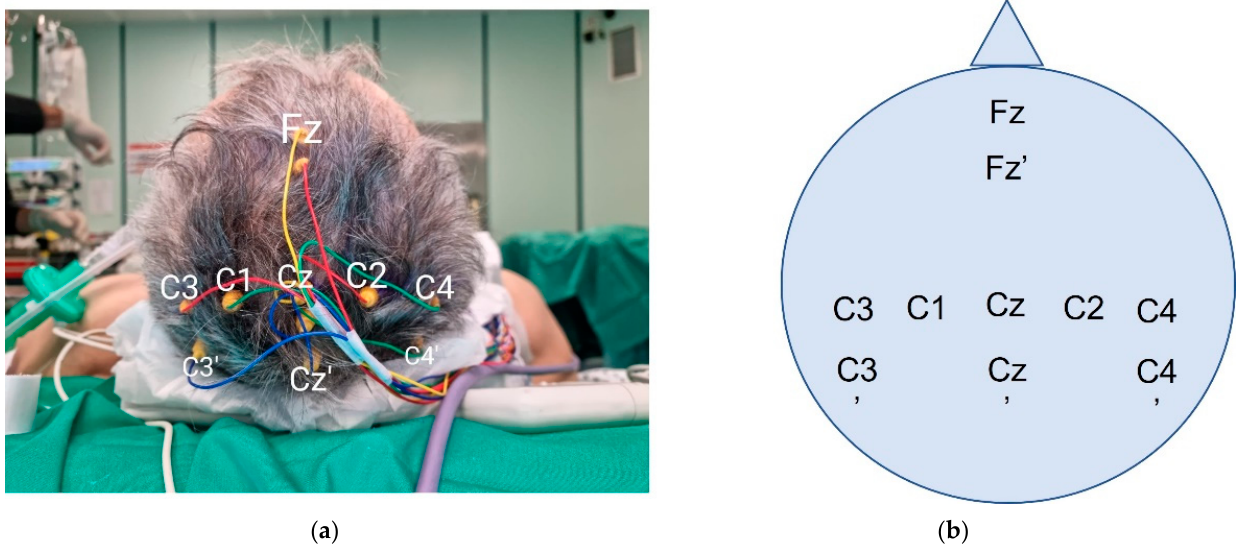
Figure 4. Intraoperative corkscrew scalp positioning (photograph ( a ) and schema ( b )). C3 and C4 are both represented in this case. The choice is dictated by the affected side. In Table 1, the parameters of stimulation and registration of evoked potentials are reported. Table 1. Technical parameters of stimulation and